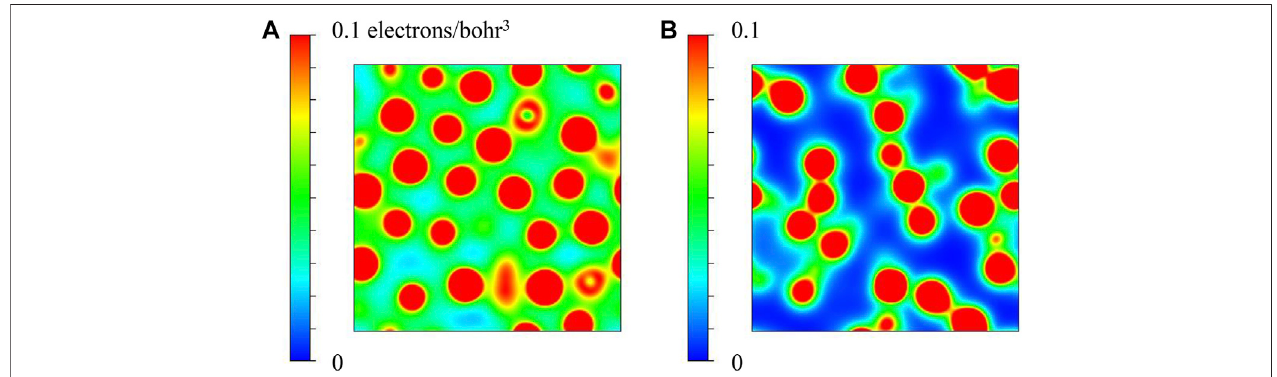
FIGURE 6 | 2d charge density diagrams of (A) Co-Fe-B and (B) Co-Fe-B-O systems (intercepted parallel to the X-Y plane at 1/2 of the Z -axis direction of the supercell).